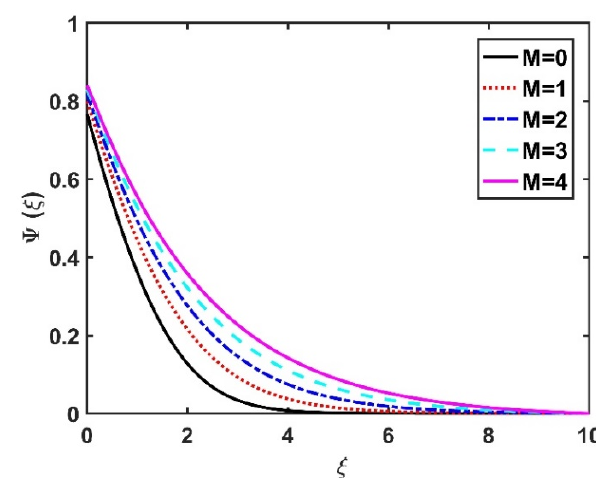
Figure 22. Impact of M on Ψ ( ξ )